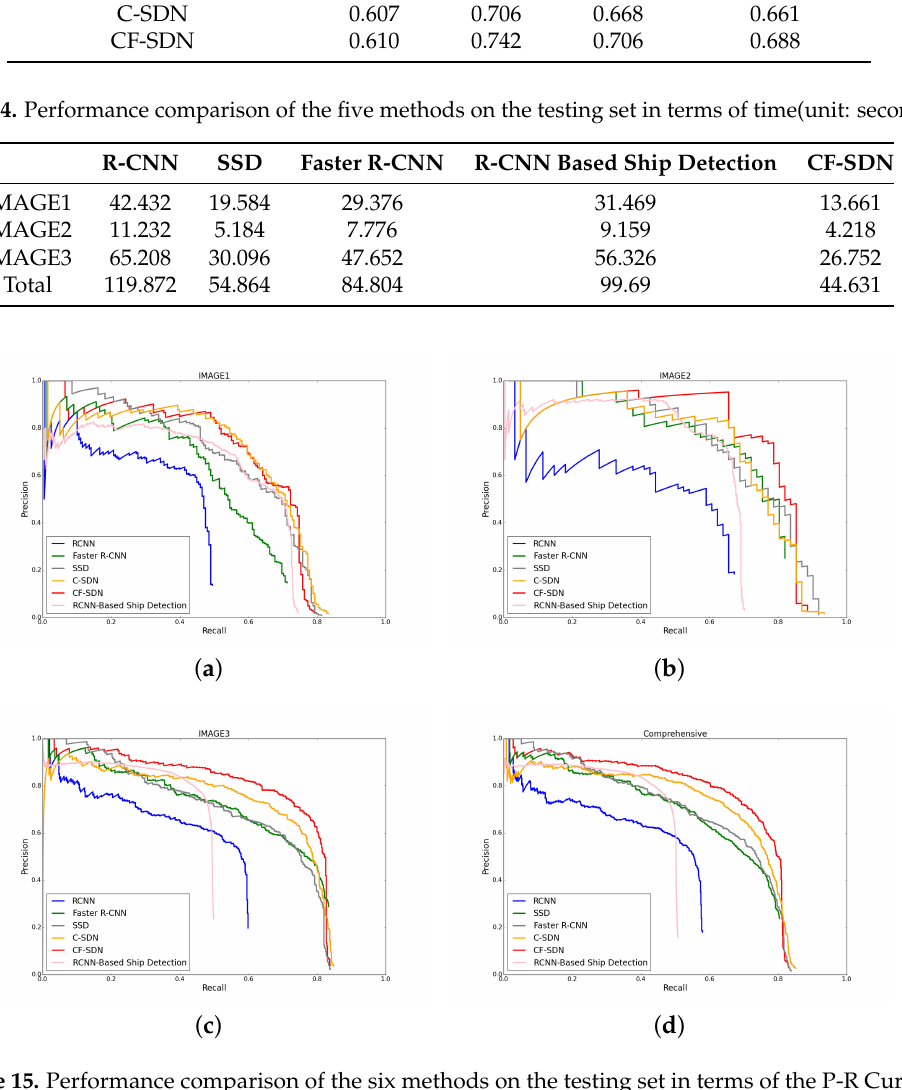
Figure 15. Performance comparison of the six methods on the testing set in terms of the P-R Curves. ( a ) Comparison of detection performance on IMAGE1. ( b ) Comparison of detection performance on IMAGE2. ( c ) Comparison of detection performance on IMAGE3. ( d ) Comparison of detection performance on the whole testing data